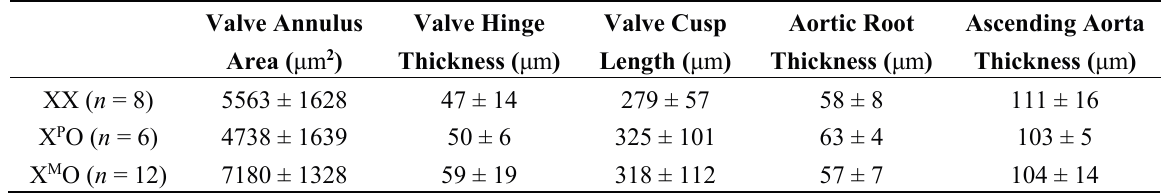
Table 1. Aortic Valve and Aorta Morphometrics in a Mouse Model of Turner